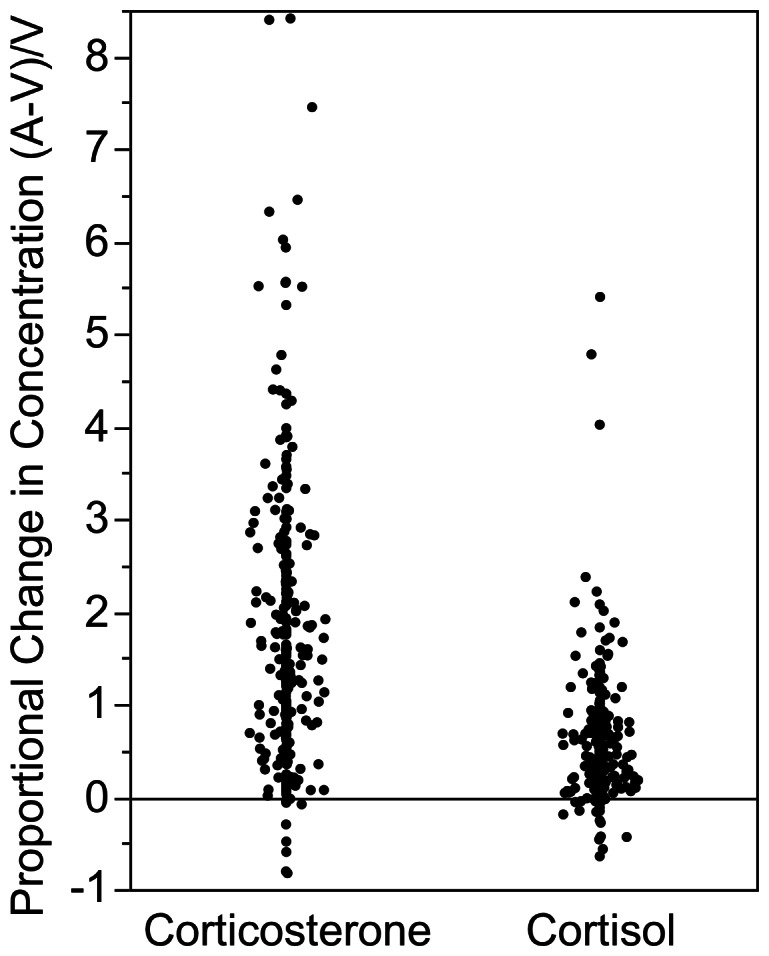
Fetal corticosteroid synthesis.Proportional change in corticosteroid concentrations after passage through the fetus ([A-V]/V) for 265 paired umbilical cord samples. Values near or below zero will include human error accidentally mixing arterial with venous blood during sampling. A value of 1.0 represents a 100% increase, or doubling, of the concentration of corticosteroid from the umbilical vein to the umbilical artery. As the data are intrinsically paired within individuals, statistical comparisons are not shown.